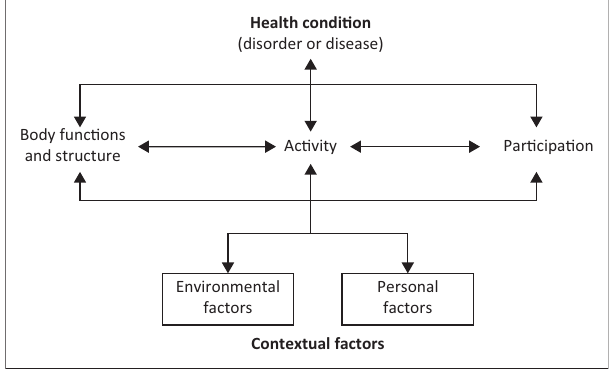
Health condi(cid:19)on (disorder or disease)